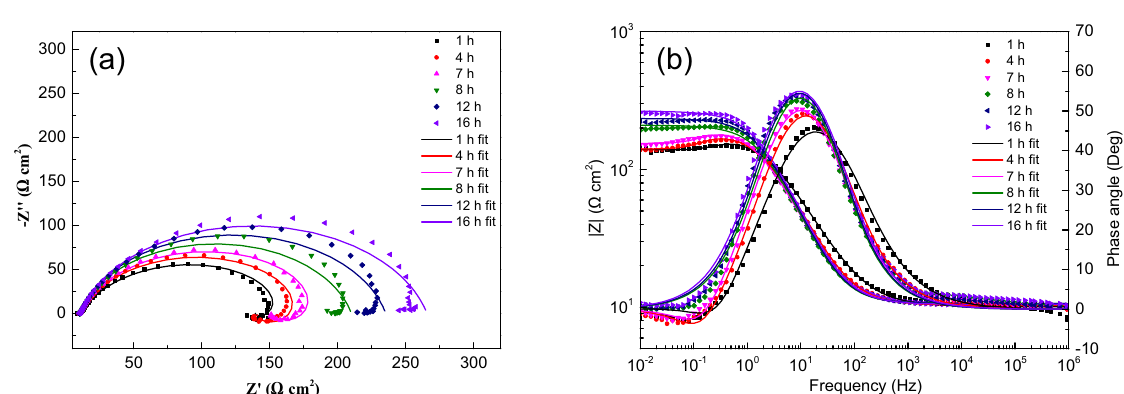
Figure 4. EIS spectra for sample with ADP under static liquid film, h = 2.5 mm: ( a ) Nyquist plots, ( b ) Bode and |Z| plots.